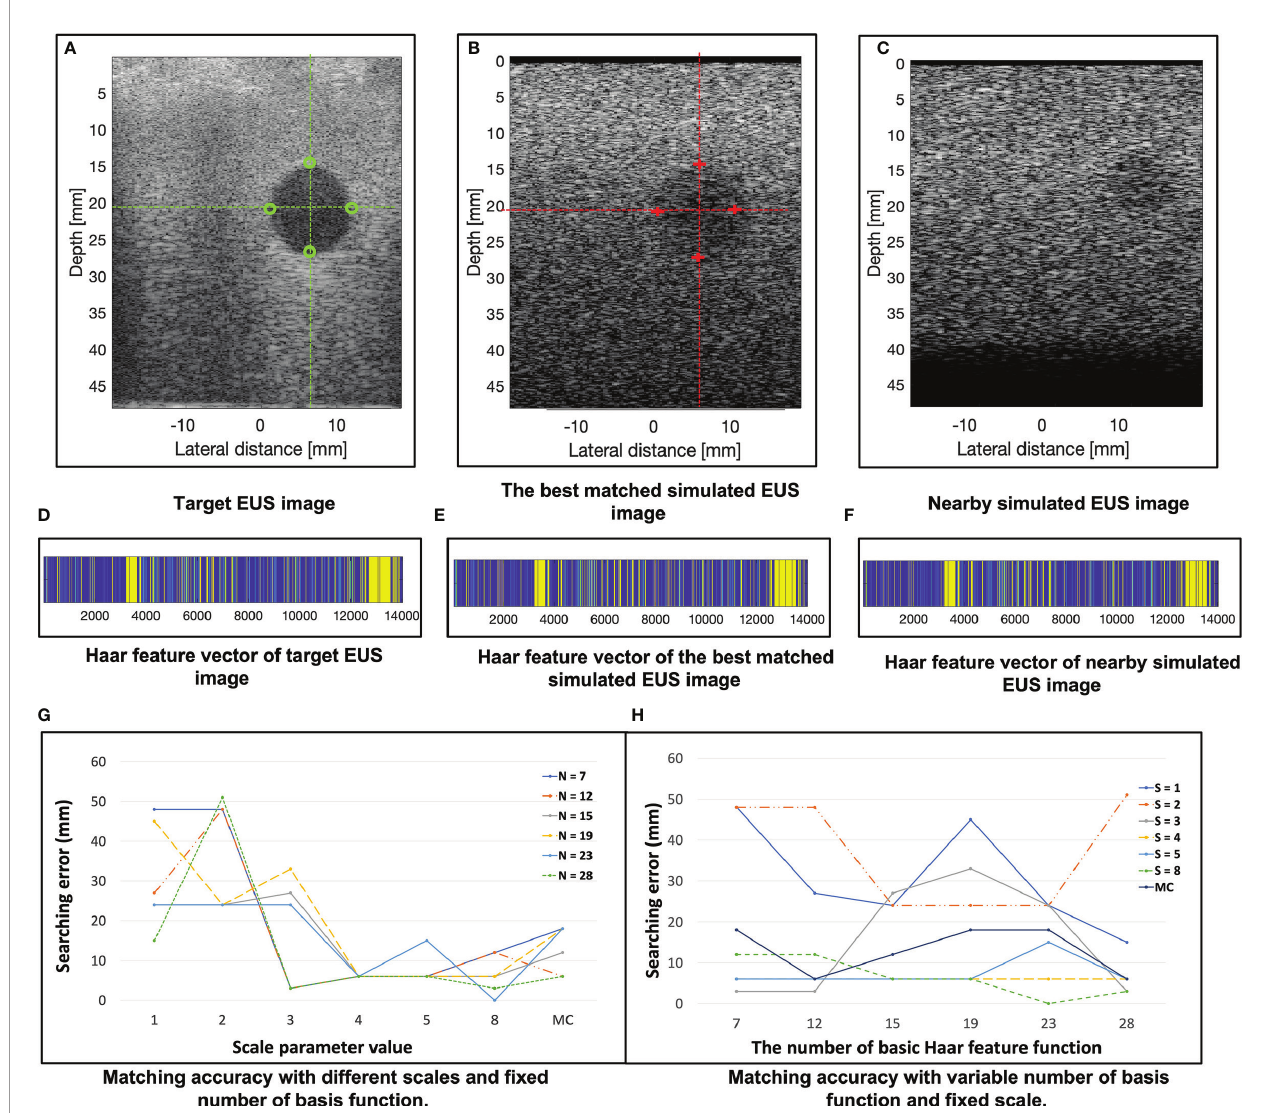
FIGURE 7 | (A – C) show the target EUS image, the corresponding best matched simulated EUS image, and one simulated EUS image with a different target nearby the best matched one. Four marker points are measured in the target EUS image and the best simulated US image. The green circles and red crosses represent the marker of the target EUS image and best matched simulated EUS image, respectively. (D – F) show the Haar feature vector of target EUS image, best matched simulated EUS image, and nearby simulated EUS image, respectively. (G) plots the results of matching accuracy with different scales and fi xed number of basis functions. N is the number of basis functions. MC is a combination of multiple scales. (H) plots the results of matching accuracy with a variable number of basis functions and fi xed scales. S is the scale of the basis function. MC is a combination of multiple scales. The error is calculated as the distance error of the four marker points of each target between the target EUS image and the corresponding best matched EUS